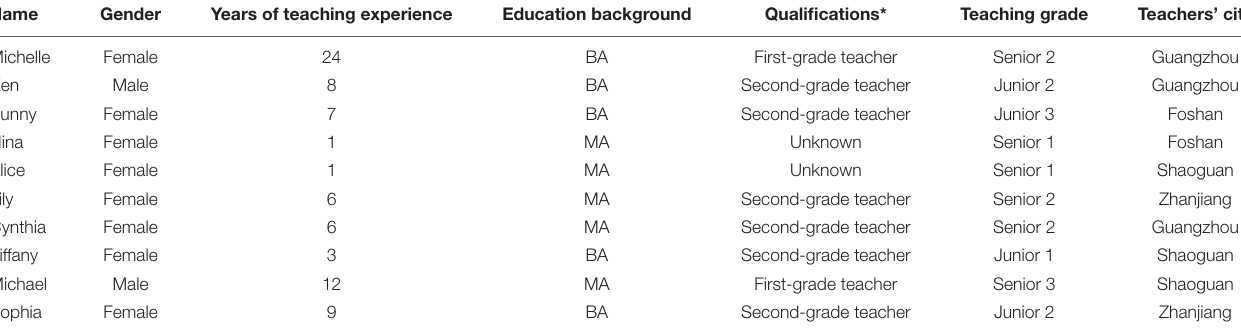
TABLE 1 | Demographic information for the teachers who participated in the interview.